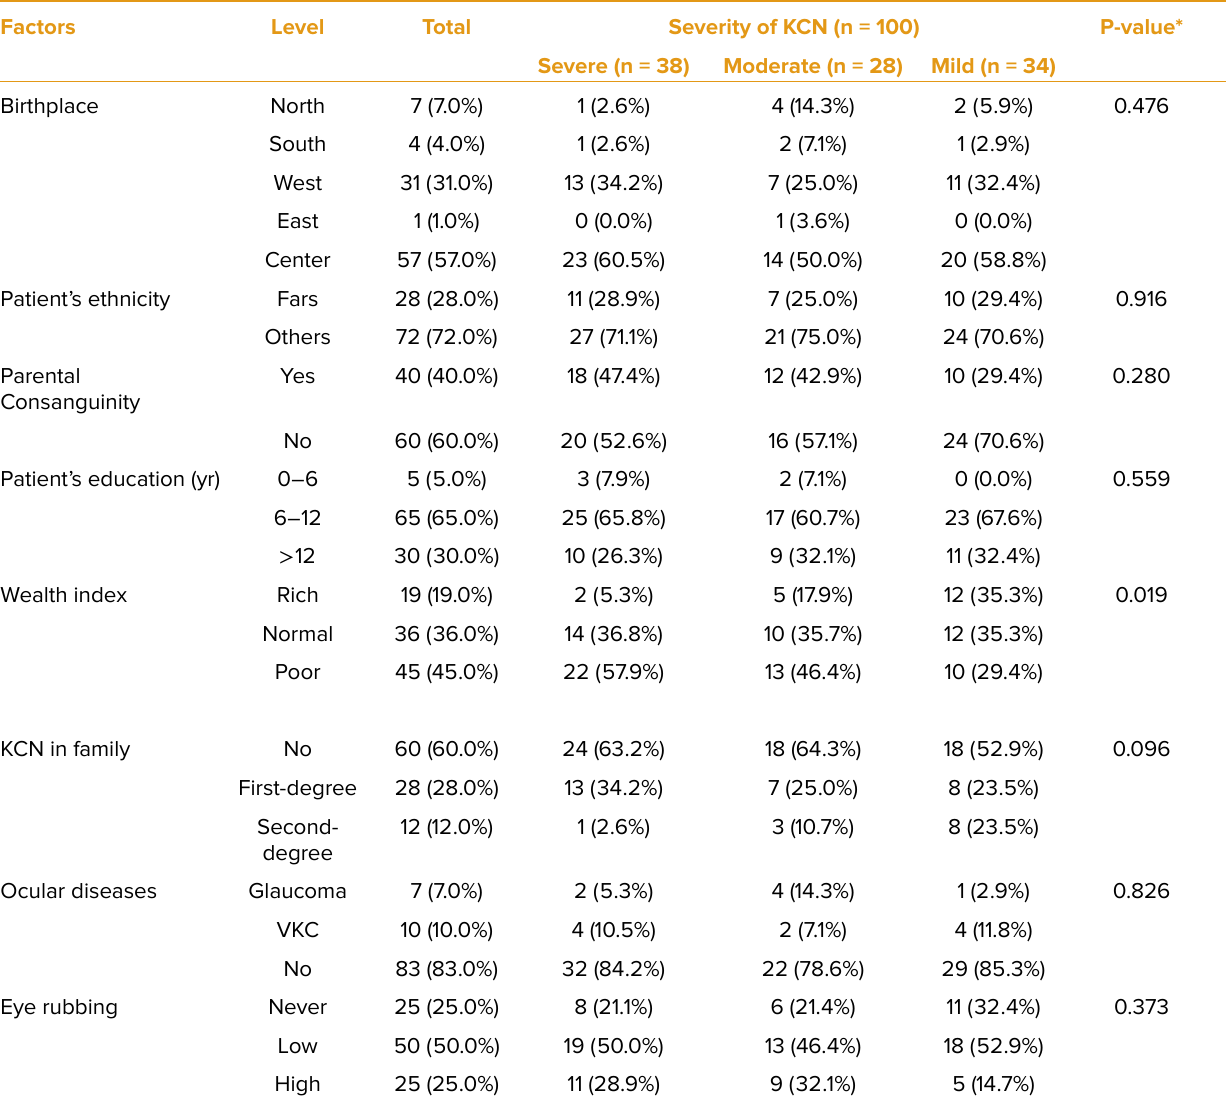
Table 4. The stages of keratoconus and possible associated factors for severity.